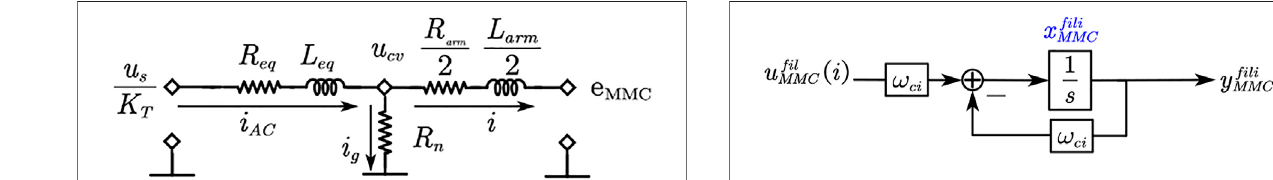
FIGURE 4 | Principle diagram of fi